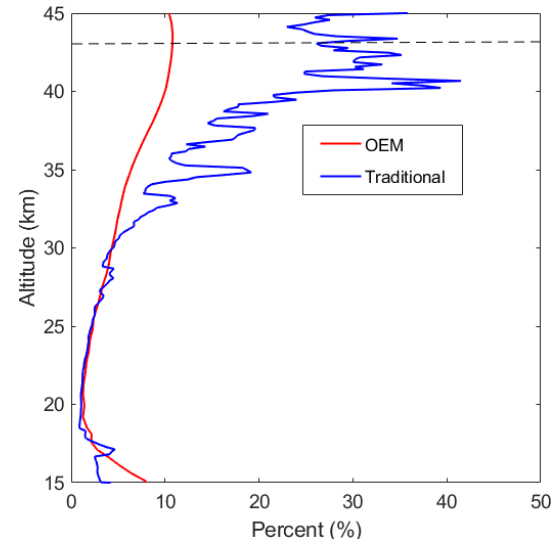
Figure 7. The traditional statistical uncertainty (blue curve) is plot- ted when the retrieval has the same vertical resolution as the OEM; the statistical uncertainty of the OEM is plotted in